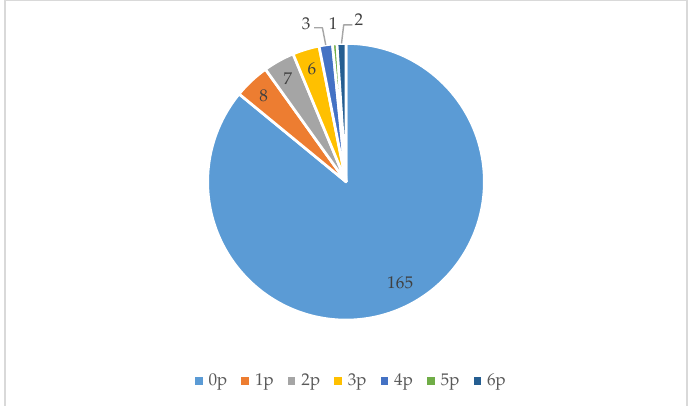
Figure 8. The number of people (p) observed during each measurement at Location 2.